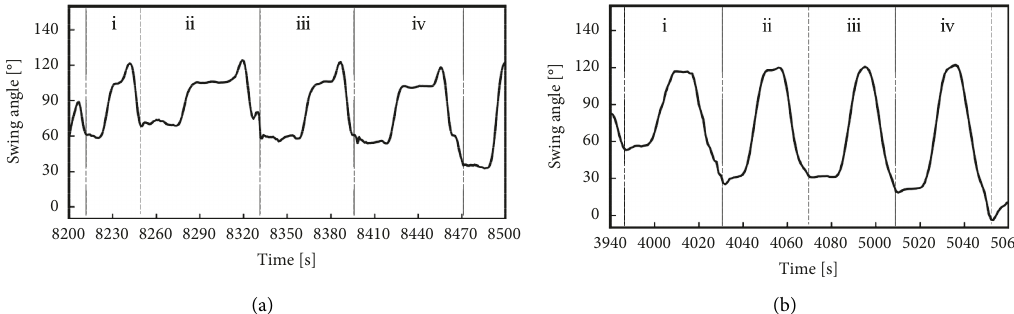
Figure 7: Long and short data classes of the loading model. (a) Four long loading cycles denoted by Class1; (b) four short loading cycles denoted by Class2.